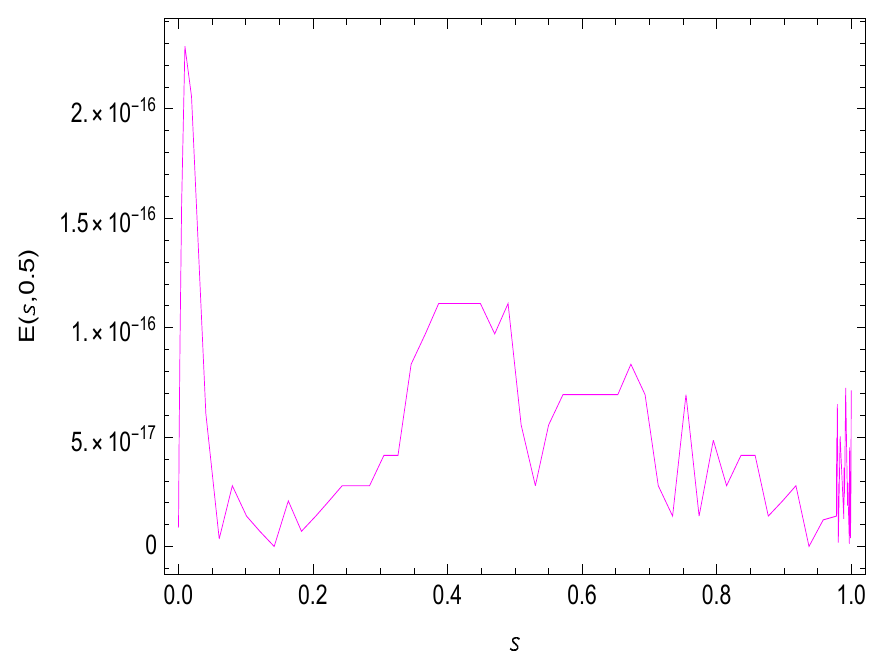
Figure 9. η -absolute errors of the problem (18), where ε = 1.1, ν = 0.5 and N = M = K = 18.